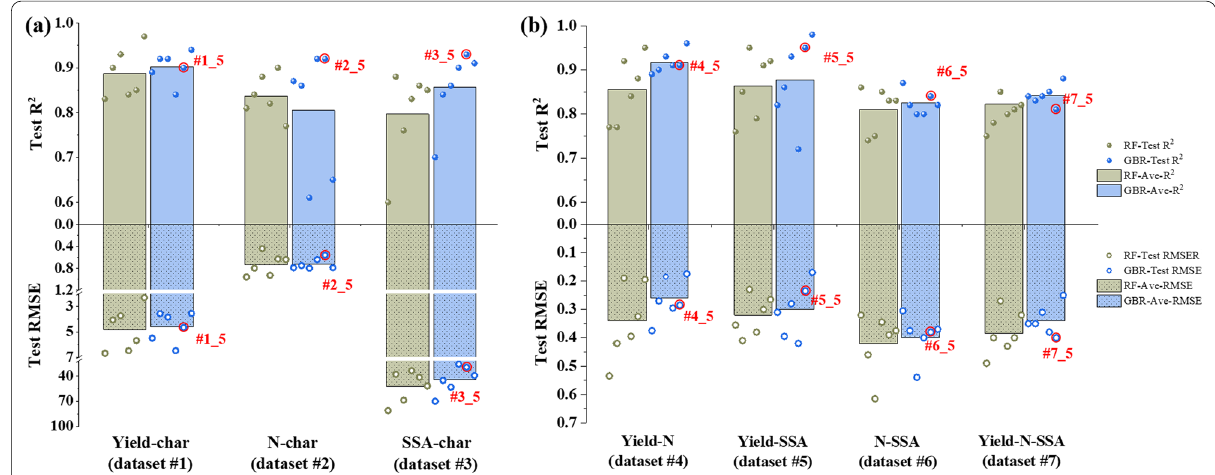
Fig. 3 Test R 2 and RMSE of the 42 ML predictions and the average test R 2 of datasets #1-#7 for a single-target predictions and b multi-target